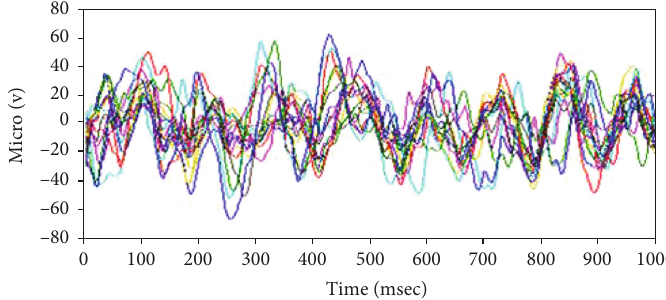
Figure 3: Time series for subject at the end time seconds in the case of close eyes.